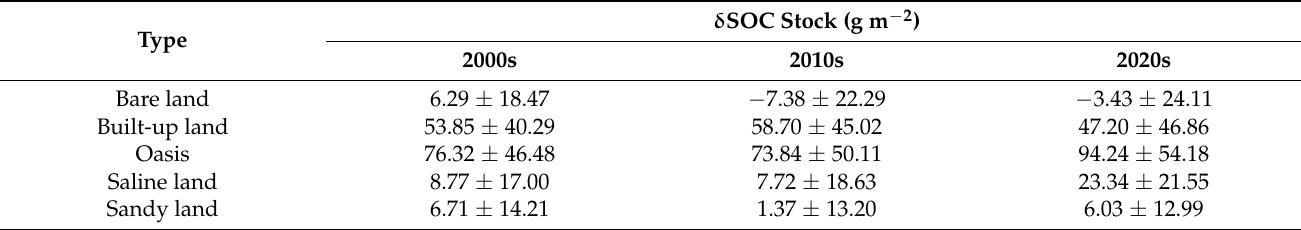
Table 4. Summary of the area-weighted averages and standard deviations of SOC stock differences ( δ SOC stock) by land use and land cover type under salt-stable scenarios for the 2000s, 2010s, and